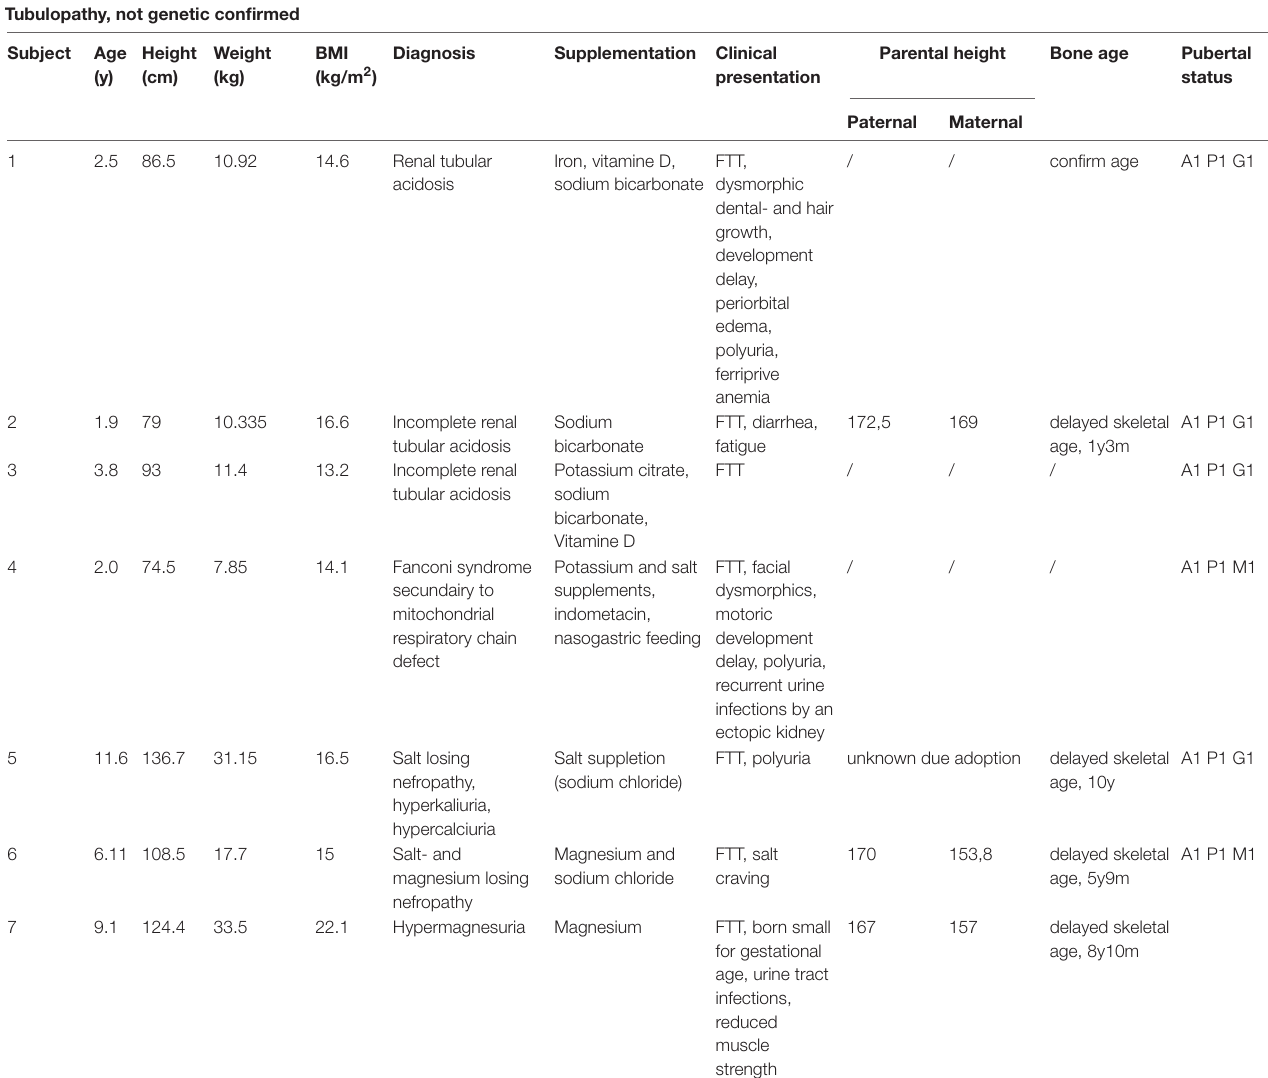
TABLE 2 | Overview of the patients’ characteristics without a genetically proven tubulopathy. Tubulopathy, not genetic confirmed